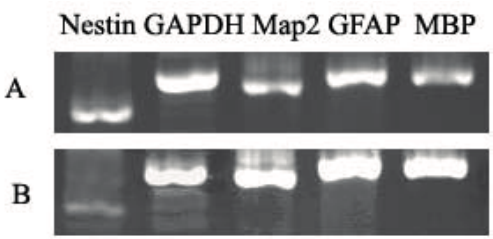
Figure 4. DNA electrophoretic analysis of neurogenic cell marker. RT-PCR analysis of induction group indicated higher expression levels of MBP, Map2 and